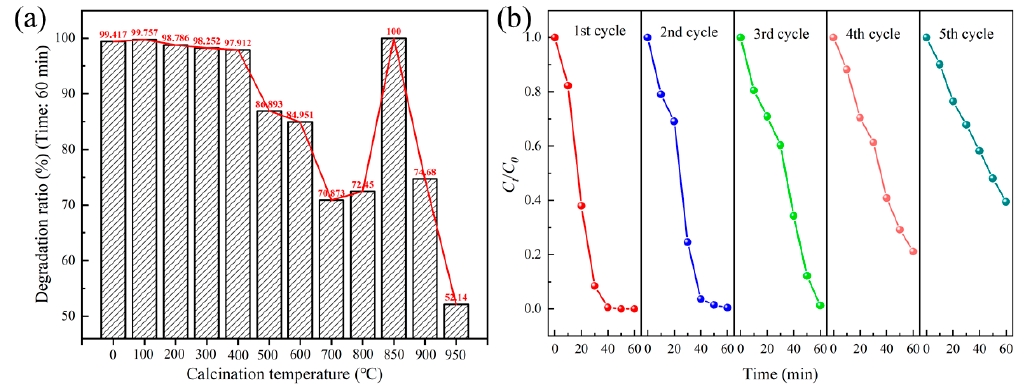
Figure 2. The degradation of RhB in the presence of PMS and chrysotile calcined at different temperatures ( a ) and reusability of 850CC ( b ). Control conditions: (PMS) = 1 mM, (XCC) = 1 g/L, (RhB) = 10 mg/L, temperature = 30 °C.